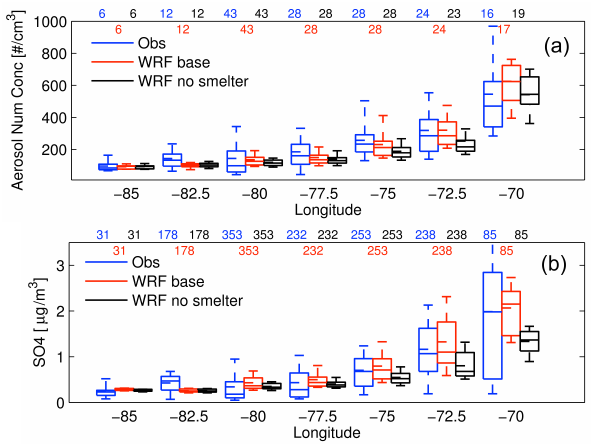
Fig. 7. (a) Comparison of aerosol number concentration between 0.12 and 3.0µm as observed from the C-130 (blue) vs. WRF-Chem model results with smelter emissions (red) and without smelter emissions (black) for the 15 October 2008 to 15 November 2008 time period. Data are gridded into 2.5 degree longitudinal zones be- tween 22 ◦ S and 18 ◦ S. The number of profiles is indicated at the top of each longitude bin. (b) Same but for measured (Allen et al., 2011) and modeled sulfate mass between 0.04µm to 0.625µm, with sam- pling time in minutes in each longitude bin indicated at the top. For each zone, center solid (dashed) lines indicate the median (mean), and boxes indicate upper and lower quartiles with upper and lower decile